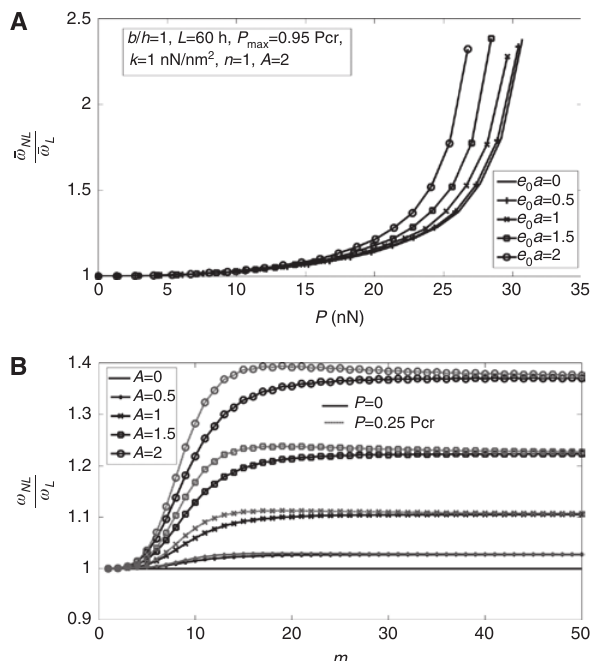
Figure 8: Effect of (A) small-scale parameter on the nonlinear to linear fundamental frequency ratio and (B) initial deformation on the nonlinear to linear frequency ratio of FG nanobeams.